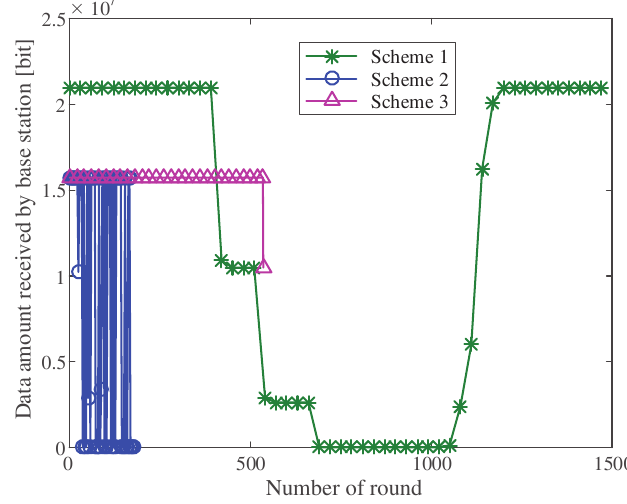
Figure 9. Comparison of the sum of the bits in three